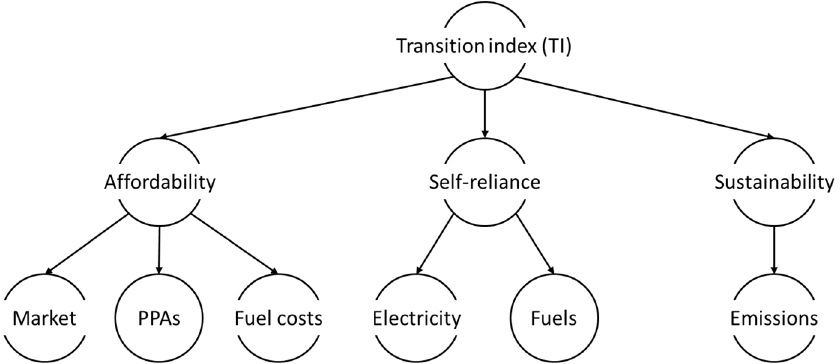
Figure 1. Energy transition index (ETI) composition.